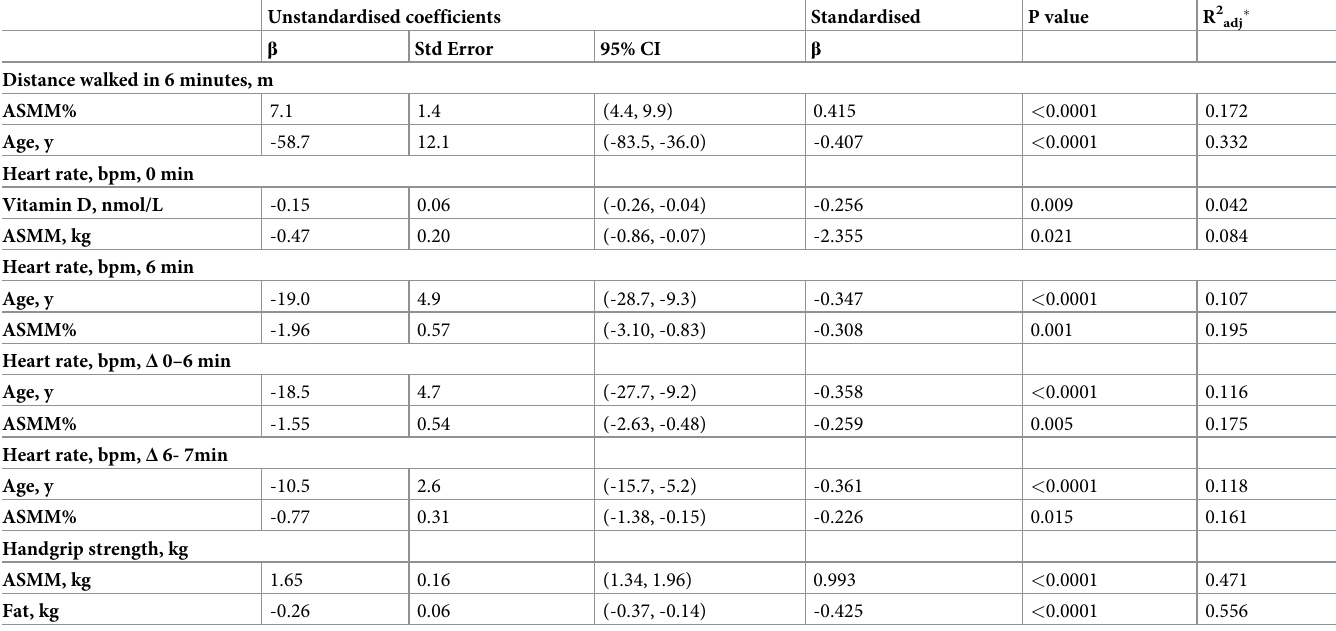
Table 5. Multiple regression analyses for prediction of physical function for 102 boys. Unstandardised coefficients